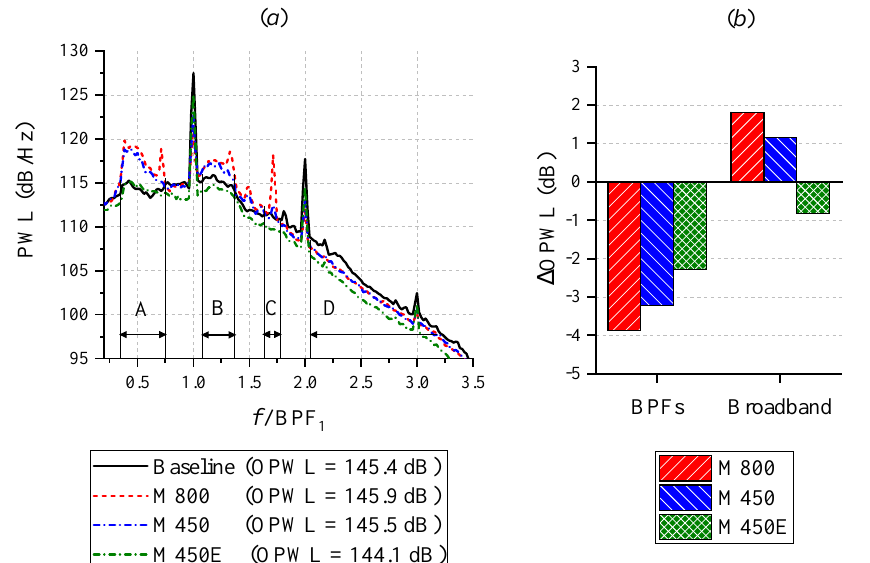
Figure 18. ( a ) Source power level (PWL) of the CRM/SDT configuration. The capital letters denote the frequency ranges where the directivity patterns are plotted in Figure 19. Plot ( b ) shows the OPWL difference between the modified configurations and the baseline, divided into two categories: BPFs (the tonal peaks BPF 1 to BPF 3 ) and broadband (the broadband noise component and other tones up to f /BPF 1 =